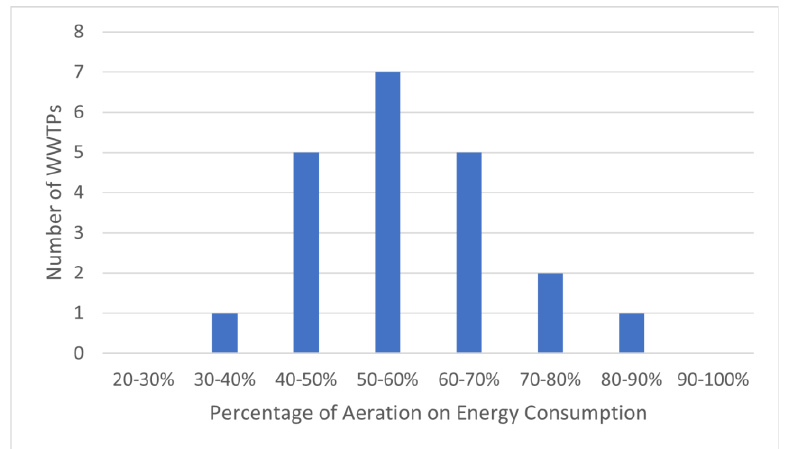
Figure 4. Percentage of Aeration Energy Consumption.